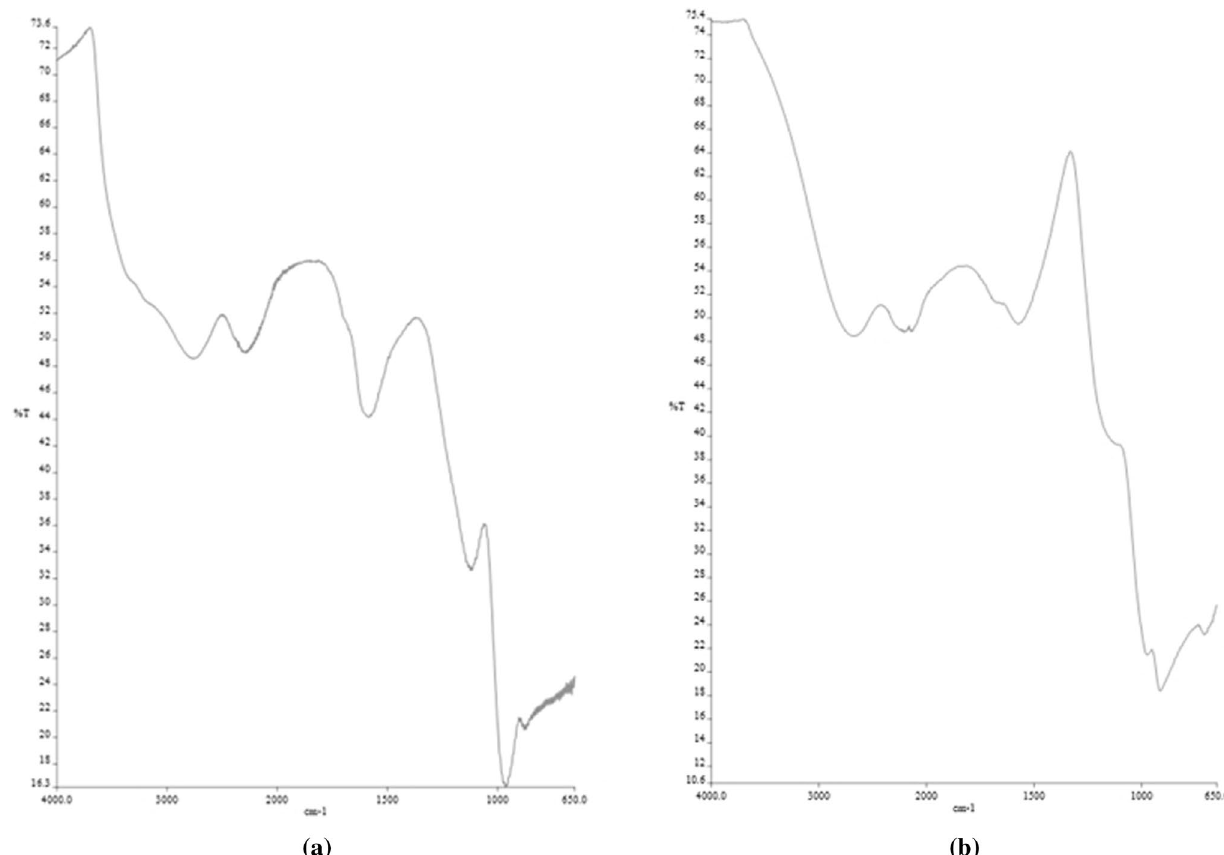
Fig. 9 FTIR spectra of the hazelnut shell sample a after 30% H